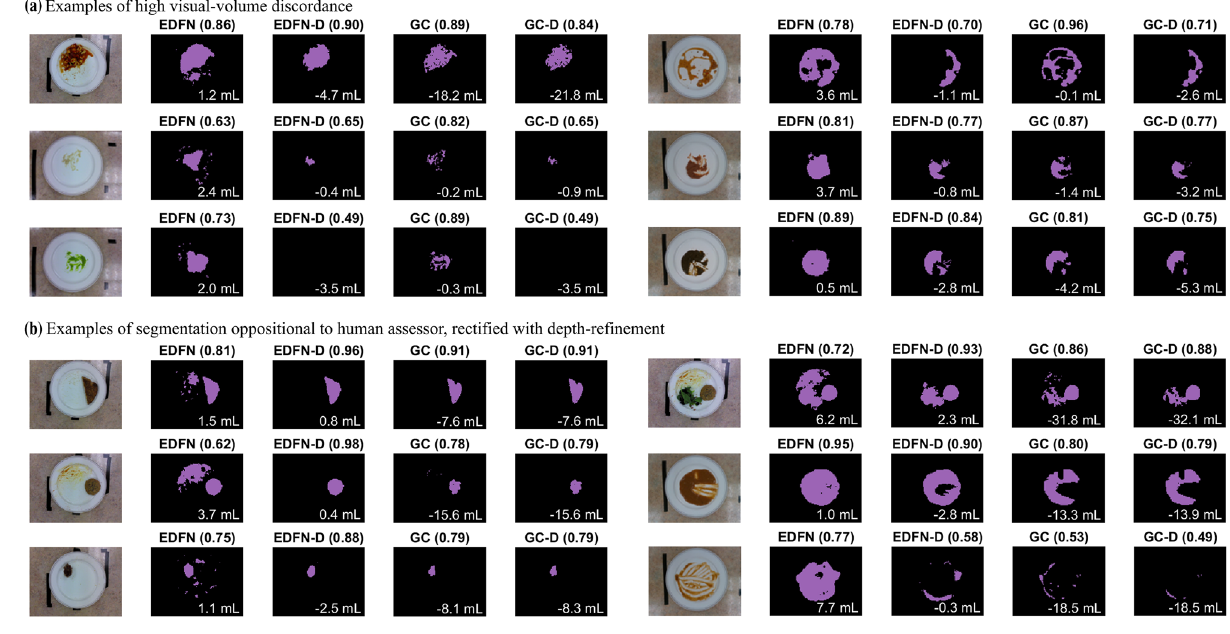
Figure 3. Visual comparison of proposed method (EDFN) and our “applied ground truth” (GC) both without and with depth-refinement (EDFN-D, GC-D). Examples span both regular and modified textures and illustrate ( a ) plates with high visual-volume discordance, as well as ( b ) examples where depth-refinement rectified oppositional segmentation compared to human assessor. IOU is shown in black bold at the top of the frame while volume error (mL) is indicated in white text at the bottom of each frame; negative volume error implies under-segmentation (i.e., over-estimation of intake).